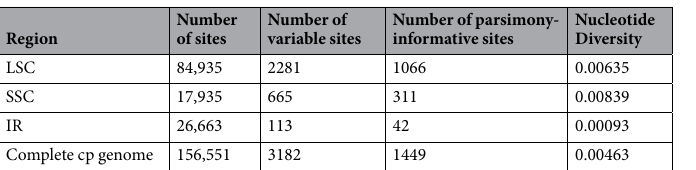
Table 3. Variable site analyses in Lilium chloroplast